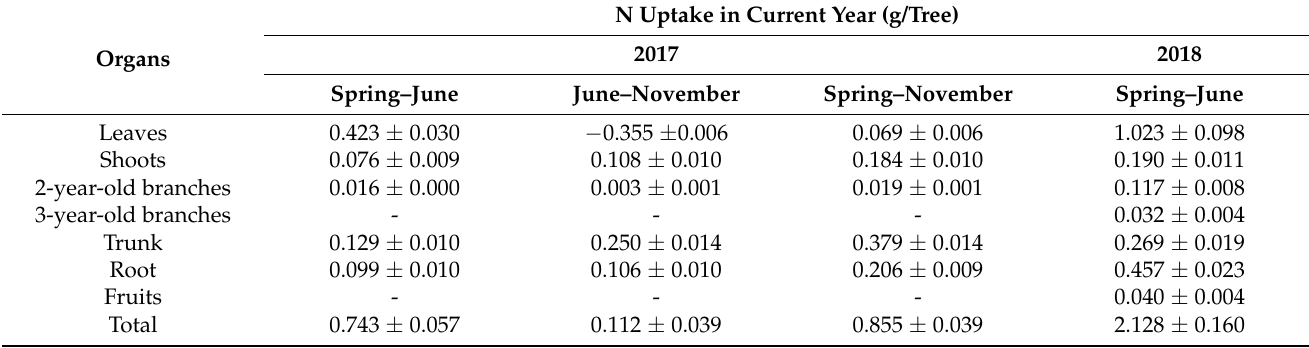
Table 2. The fertilizer nitrogen uptake in the current year distributed in various organs during different